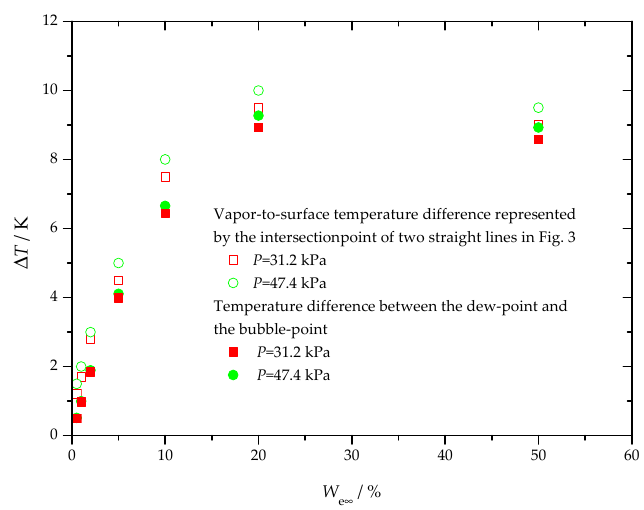
Figure 4. Comparison of vapor-to-surface temperature difference represented by the intersection point of two straight lines in Figure 3 and the temperature difference between the dew-point and the bubble-point.